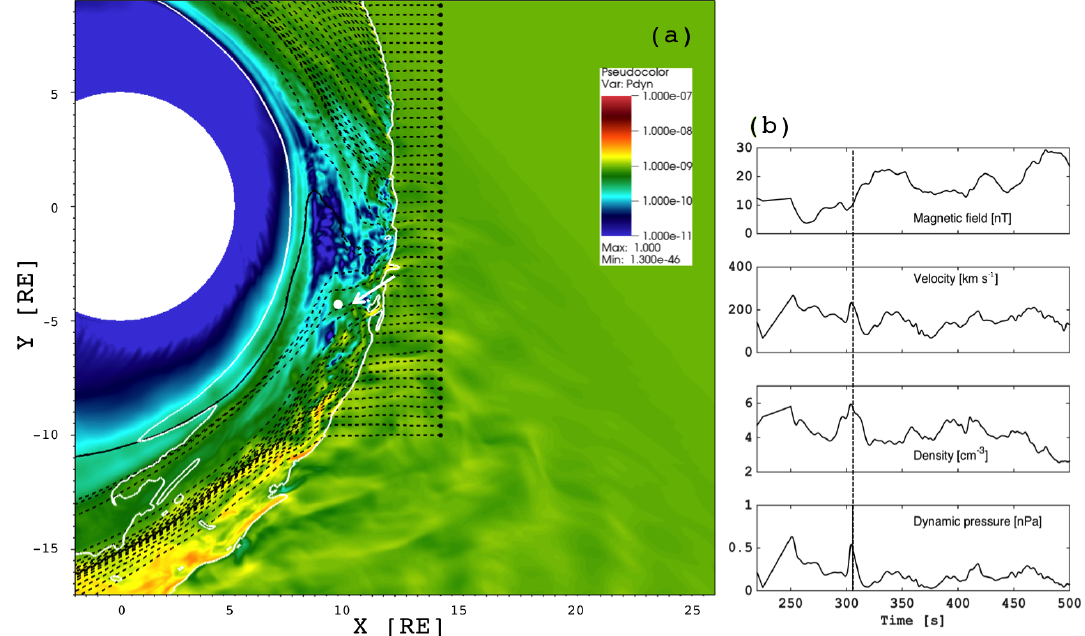
Figure 1. (a) Dynamic pressure within the Vlasiator simulation domain. Bow shock position is identified with white solid line. The black dashed lines are solar wind streamlines illustrating the magnetopause position roughly (see text for details). The figure is a snapshot of Supplement movie S1, which does not include the bow shock position or the streamlines. The arrow indicates the visually detected magne- tosheath jet under scrutiny in this paper. (b) Virtual spacecraft data from the location marked with a white dot in panel (a) : magnetic field, velocity, density, and dynamic pressure as a function of time. The dashed vertical line shows the time of the visually identified jet in panel (a)